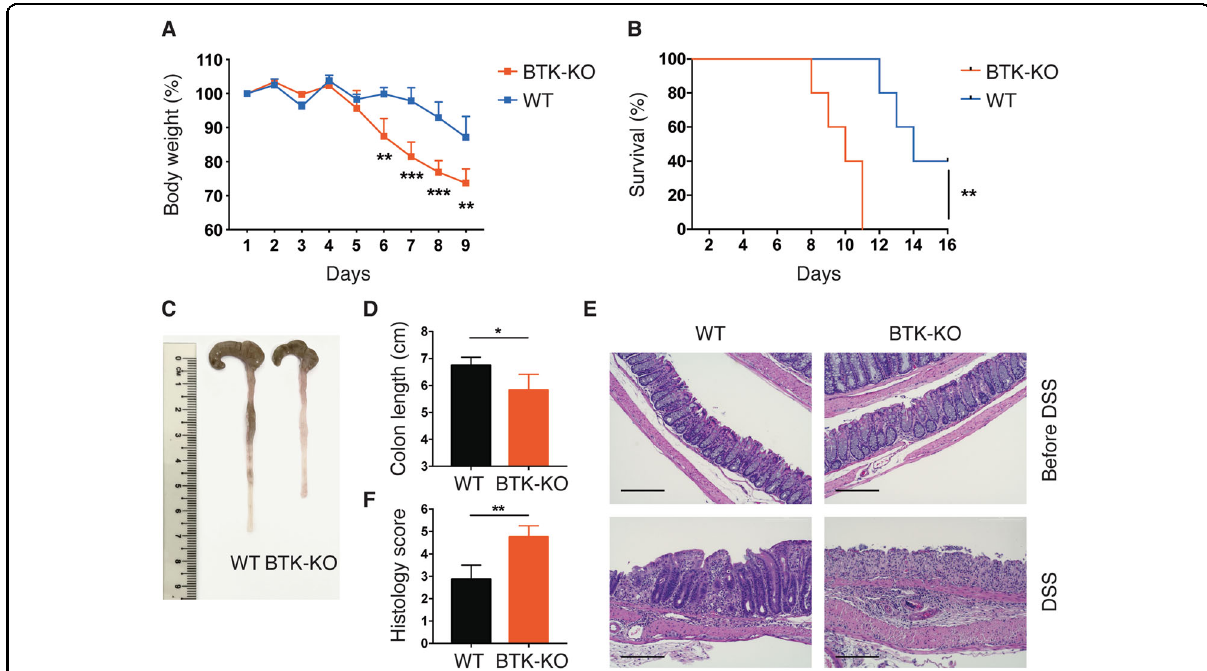
Fig. 1 BTK-KO mice are more susceptible to DSS-induced colitis. Experimental colitis was induced in WT and BTK-KO mice by feeding mice ad libitum with drinking water containing 2% (w/v) DSS for 7 days. DSS-containing water was replaced by sterile drinking water from day 8 onwards. Body weight ( A ) and survival rate ( B ) of WT and BTK-KO mice were monitored every 24 h. C , D Colon lengths were measured upon euthanasia of DSS-treated mice on day 9. E Representative images of the H&E-stained colon sections from unchallenged and DSS-treated WT and BTK-KO mice; the scale bar is 200 μ m. F The histology disease score of H&E-stained colon sections from DSS-treated WT and BTK-KO mice. Data are presented as mean ± SD ( n = 5). Statistical signi fi cance in A , D , F was determined by two-sided independent sample Student ’ s t -test. Survival rate difference in B was determined by Log-rank (Mantel – Cox) test. * P < 0.05, ** P < 0.01 and *** P < 0.001. Data shown are representative of two independent